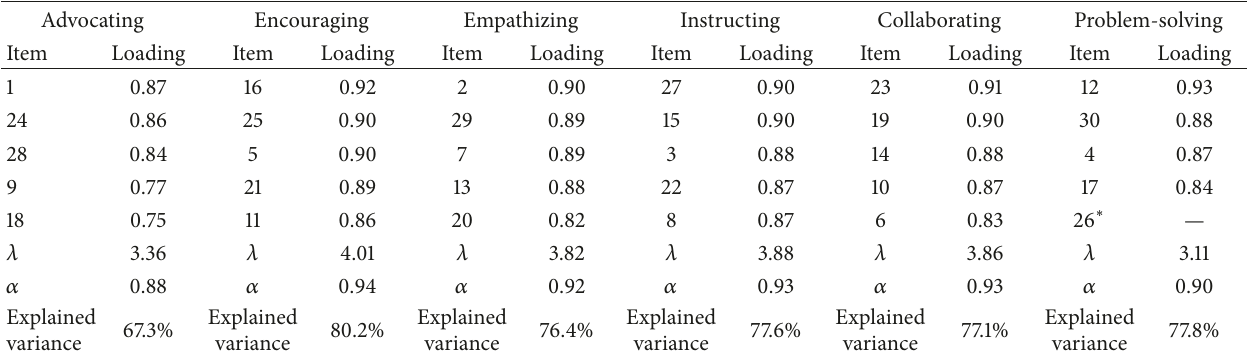
Table 2: One-component solution for the scales derived from the Norwegian client assessment of modes (adapted for the purpose of this study): items, component loadings, eigenvalue estimates ( 𝜆 ), internal consistency estimates, and explained variance ( 𝑛 = 111 ). Advocating Encouraging Empathizing Instructing Collaborating Problem-solving